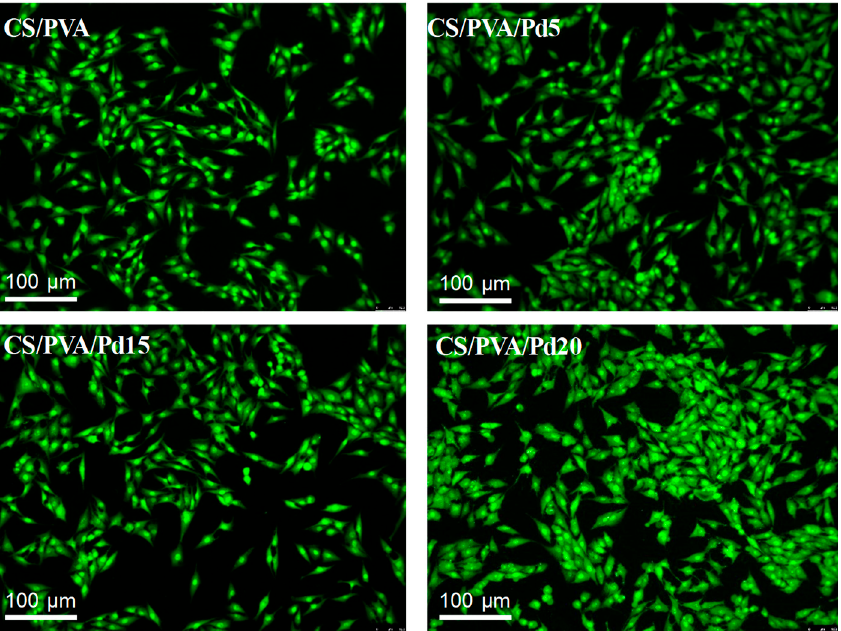
Figure 8. Cytotoxicity assay of CS/PVA and CS/PVA/Pd dressings (incubation time: 48 h).